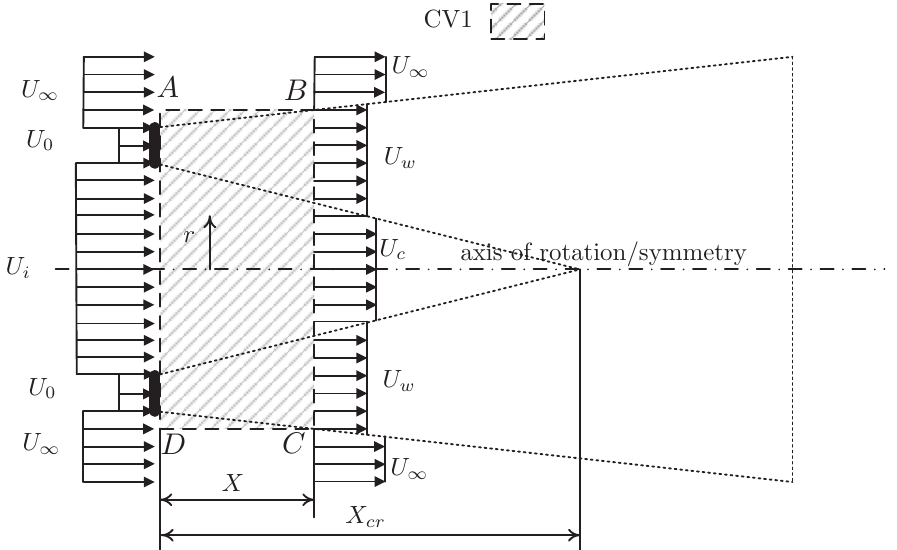
Figure 10. A schematic drawing showing the control volume CV1 (hatch pattern) whose boundaries (dashed line) are specified by ABCDA . CV1 encloses a small part of the freestream, the inner flow and the wake flow (dotted line) up to X < X cr . The inlet is specified by AD ( X = 0), the outlet by BC (0 < X < X cr ), and the side boundaries by AB and CD . The thick line at X = 0 represents the area swept by the kite; also, r represents the radial distance from the axis of